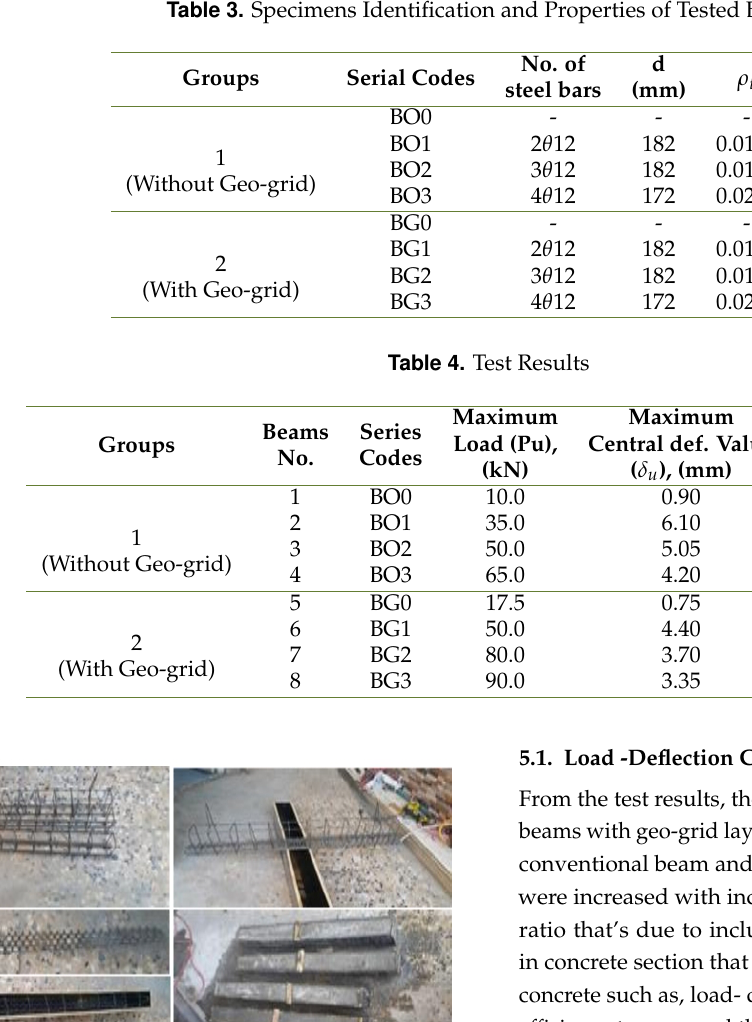
Table 3. Specimens Identification and Properties of Tested Beams